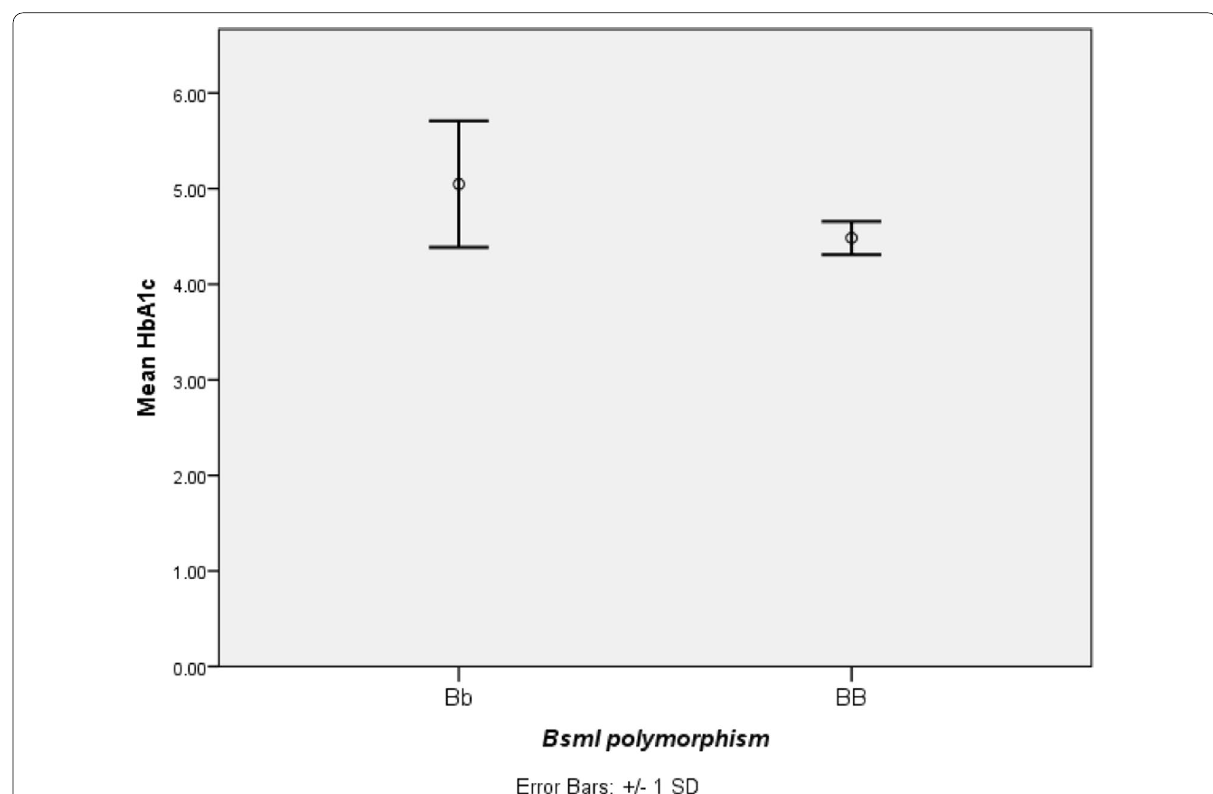
Fig. 3 Relation between BsmI polymorphism and HbA1c